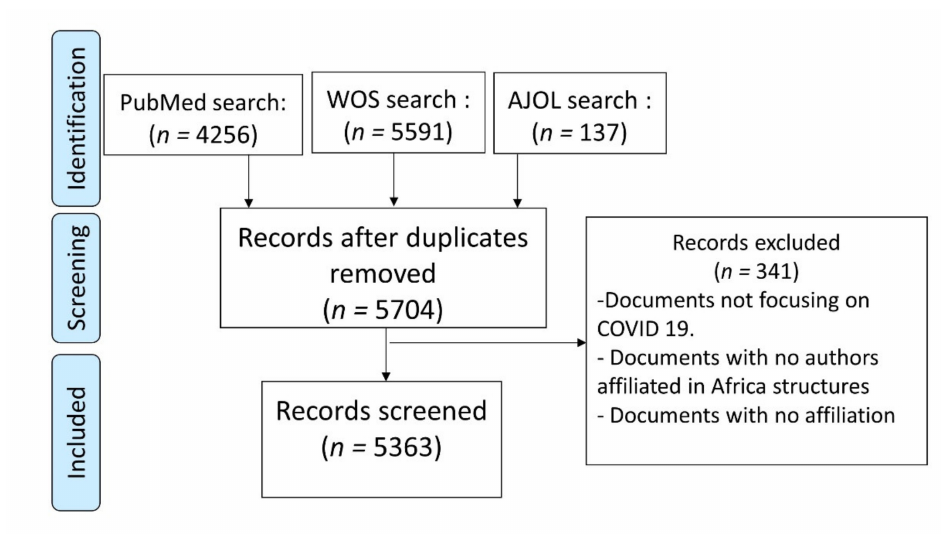
Figure 1. Flow-chart showing the selection process of articles included in the